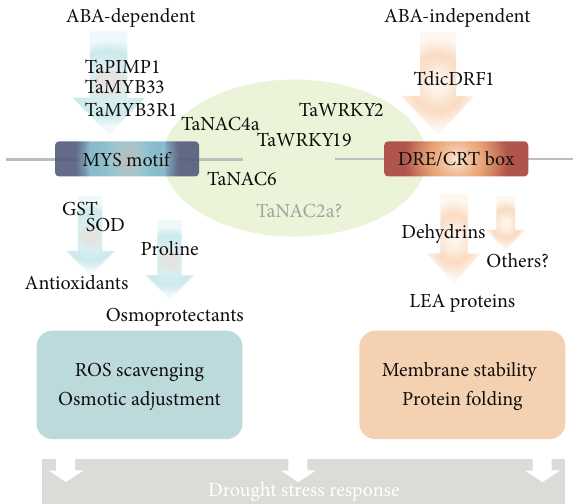
Figure 1: ABA-dependent and ABA-independent pathways of stress response. MYB and DREB TFs are given as examples to ABA- dependent and-independent routes. While ABA-dependent path- waysappeartorecruitantioxidantandosmoprotectantmechanisms, ABA-independent pathways generally involve protective proteins. NAC and WRKY TFs provide crosstalk between these pathways; where some members, such as TaNAC4 and TaNAC6, may pre- dominantly act in an ABA-dependent fashion, some members may be closer to ABA-independent pathways. In several cases, such as TaWRKY19, both pathways are employed. It should be noted that both pathways are highly intermingled, and functions of several regulators, such as TaNAC2a, as well as entire pathways are yet to be